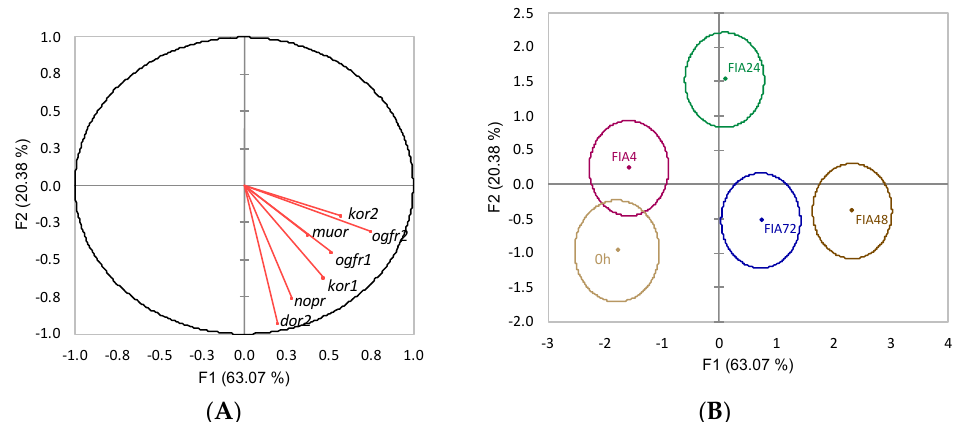
and dor2 , B ) in undisturbed European seabass (0 h, ) or i.p.-injected with a sham solution (CTRL, □ ) or Freund’s Incomplete Adjuvant (FIA, ■ ) and sampled at 4, 24, 48, 72 h post-injection (means ± SD, n = 8). Different symbols (* and #) stand for significant differences between i.p.-injected groups and the undisturbed group (0 h). Capital letters stand for significant differences between stimuli. Lower-case letters indicate significant differences between sampling times. Further details in legend of Figure 1.